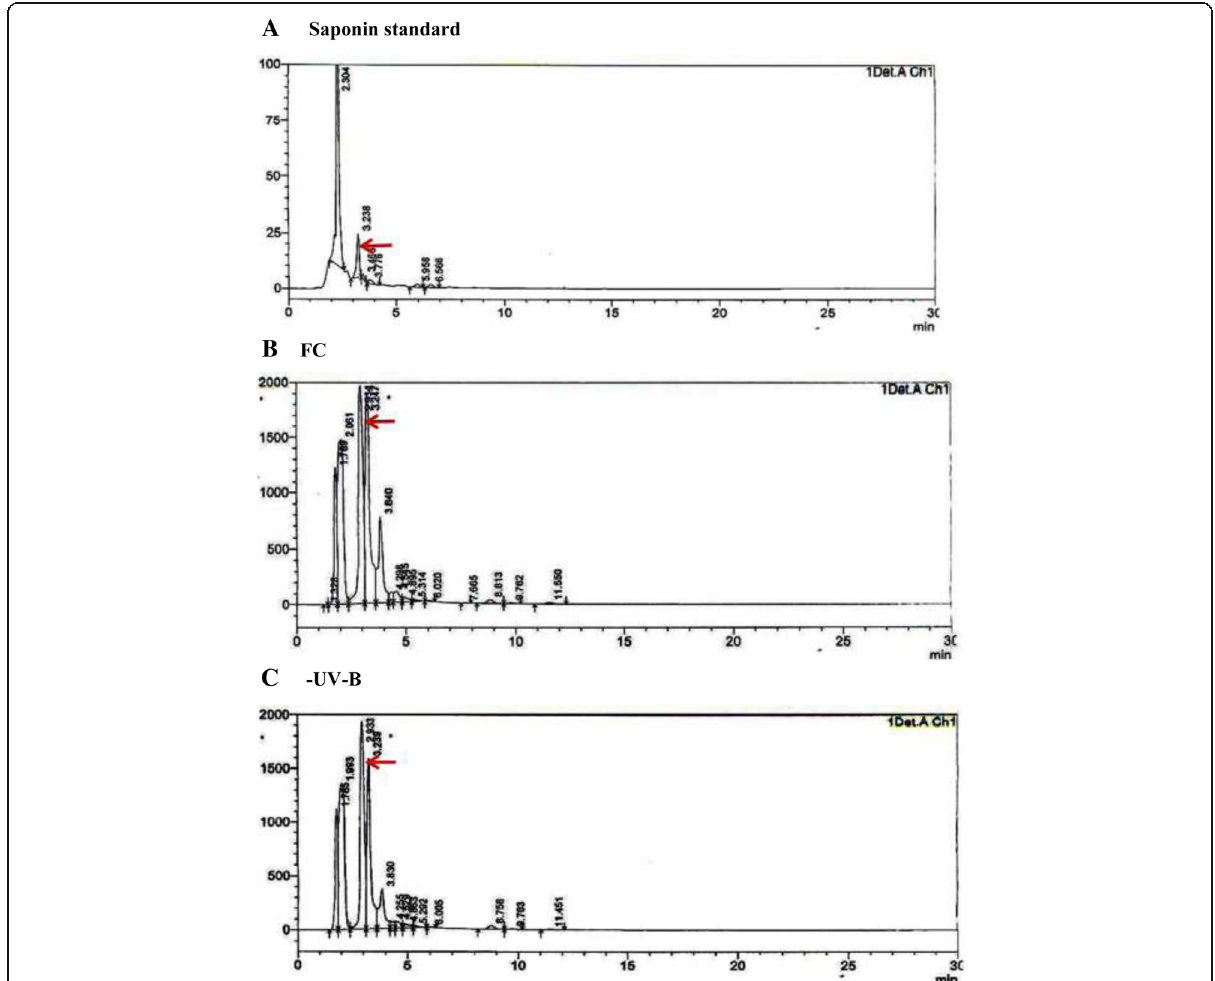
Fig. 6 HPLC chromatogram of ethyl acetate fractions extracted from leaves of cotton var. Vikram plants. Saponin standard ( a ), filter control (FC) ( b ) and UV-B excluded ( c ) leaves. Arrow indicates the peak of saponin in the samples